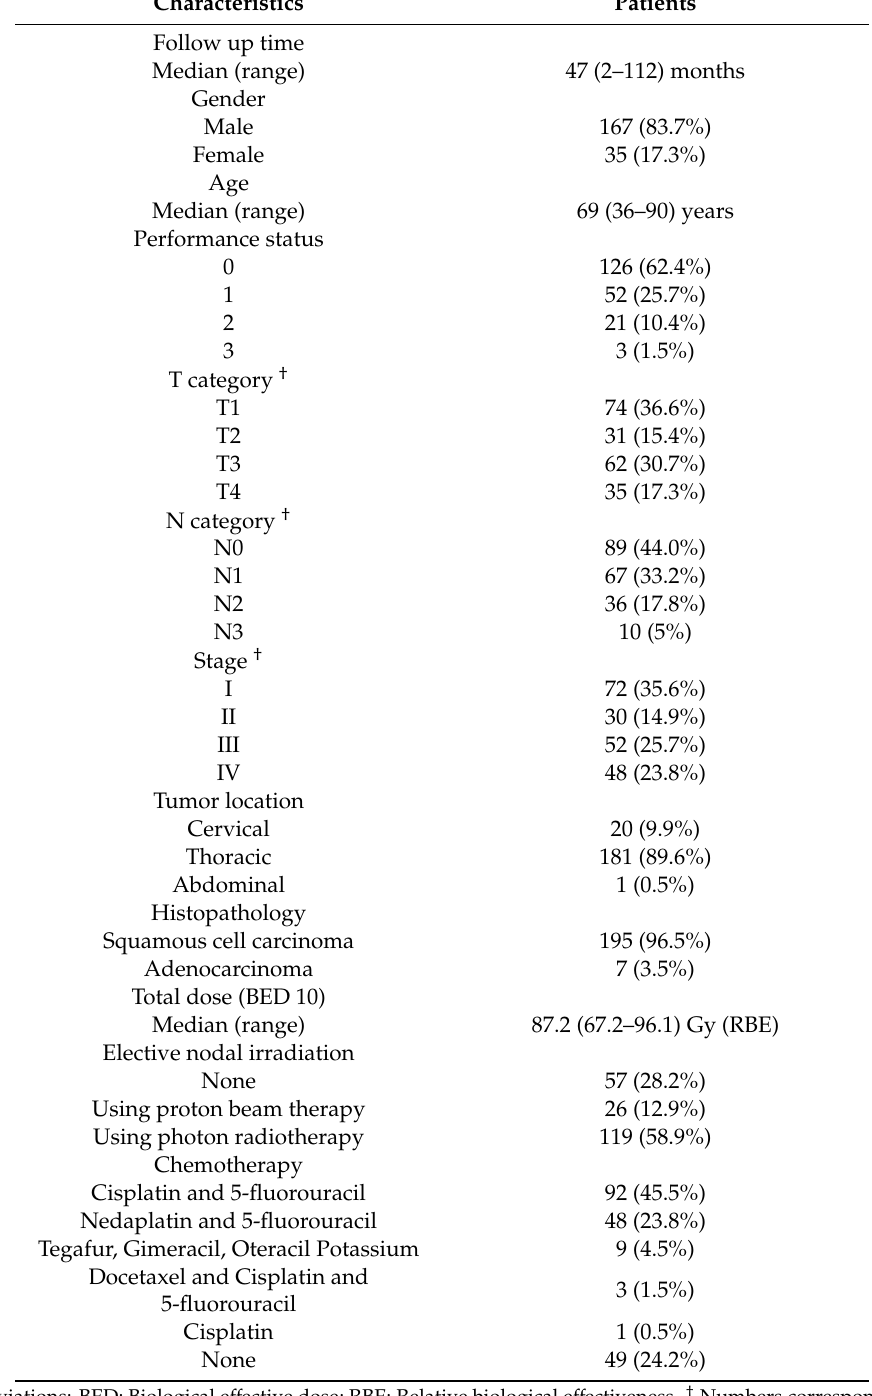
Table 1. Patient